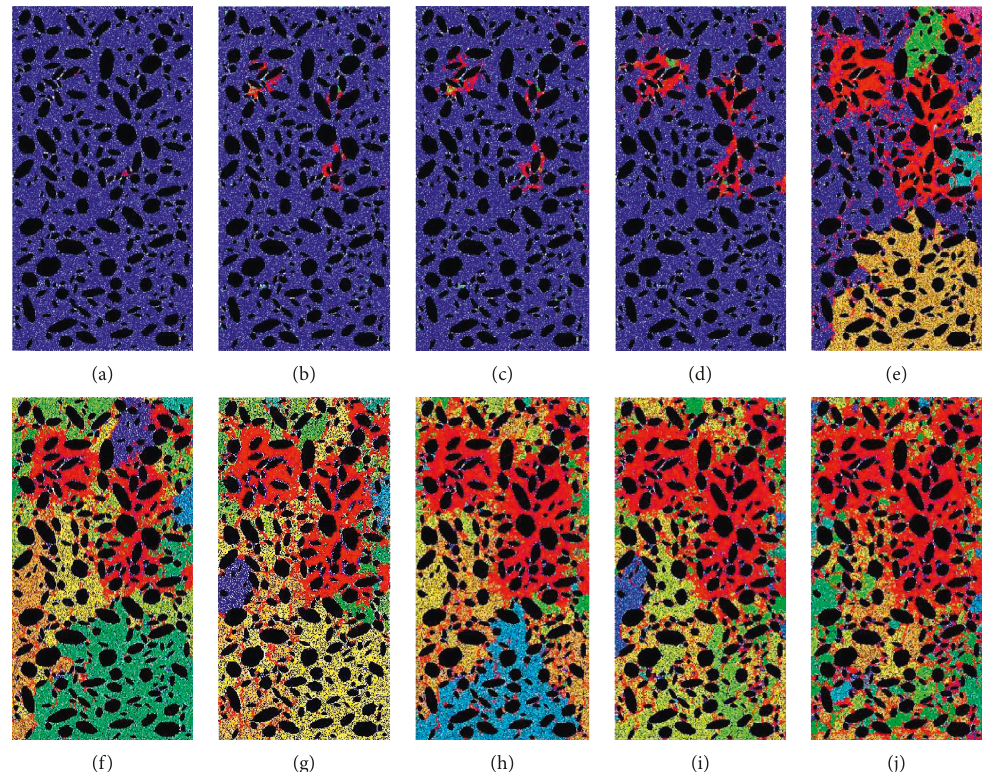
Figure 13: Distribution of the bond failure zone under different cementation degrees between particles. (a) 1 E 6. (b) 5 E 6. (c) 1 E 7. (d) 5 E 7.